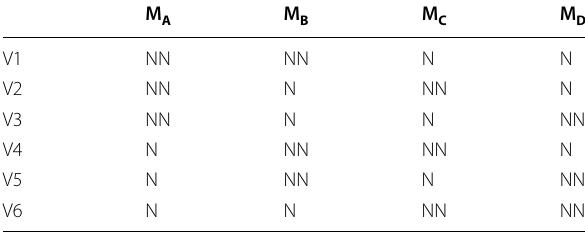
Table 3 Presentation versions used in Experiment